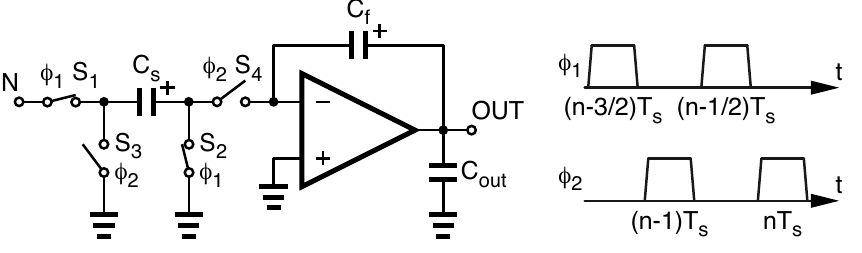
Figure 9. Forward-Euler SC